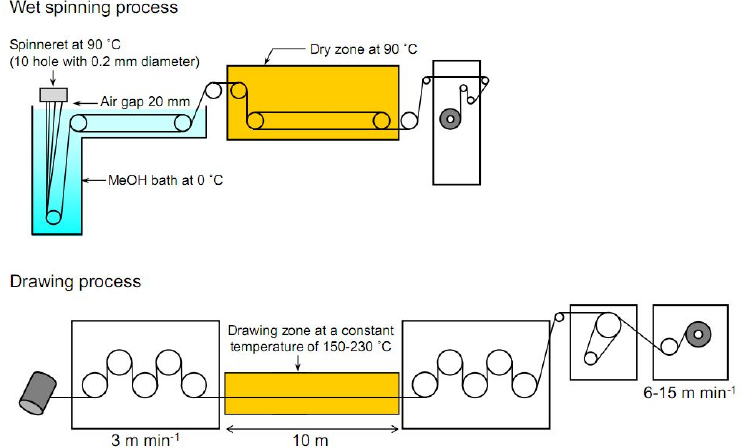
Figure 11. Scheme showing all stages during dry-wet spinning process (reprinted from Polymer , 2013 , 54 , 935–914, Endo, R.; Saito, T.; Isogai, A. TEMPO-oxidized cellulose nanofibril/poly(vinyl alcohol) composite drawn fibers, with permission from Elsevier).